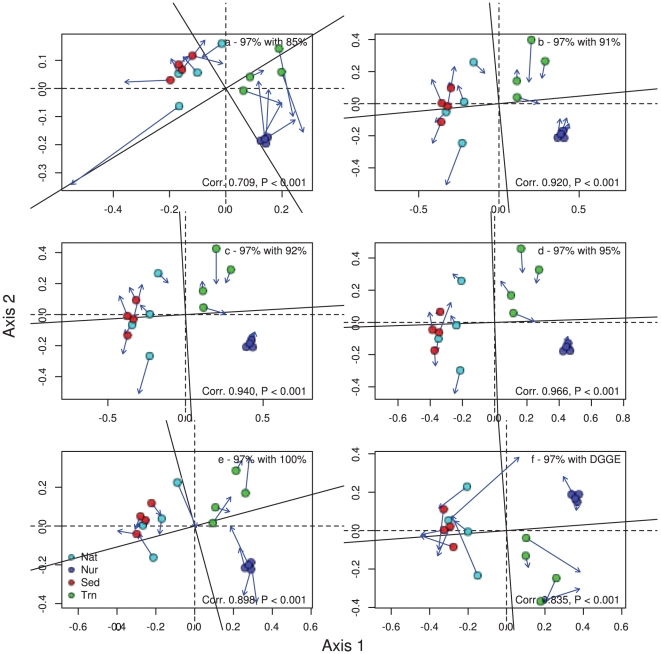
Ordination showing the first two PCO axes of the Betaproteobacteria only analysis for a) 85% cut-off level with 97%, b) 91% cut-off level with 97%, c) 92% cut-off level with 97%, d) 95% cut-off level with 97%, e) 100% cut-off level and f) DGEE data with 97% cut-off level.The arrows in the ordination point to the target configuration, the actual symbols represent the rotated configuration, i.e., the ordination based on the 97% cut-off values. Correlation (Corr) and significance values are given in the lower right corner of each graph.